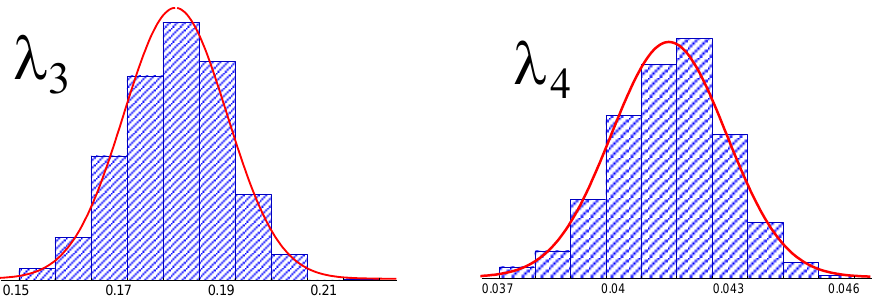
Figure 5. Plots of the probability density functions of the four GLD parameters obtained from 1000 bootstraps for the Hurst exponent of H = 0.5.